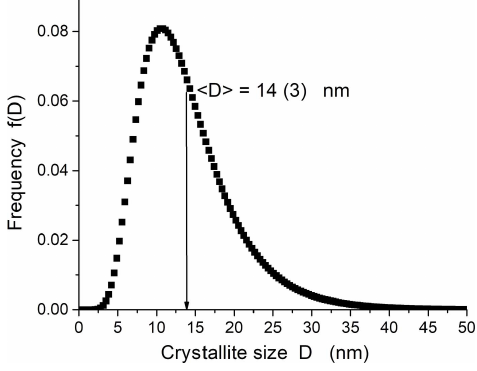
Figure 13 Crystal size distribution for ball-milled CaF2.